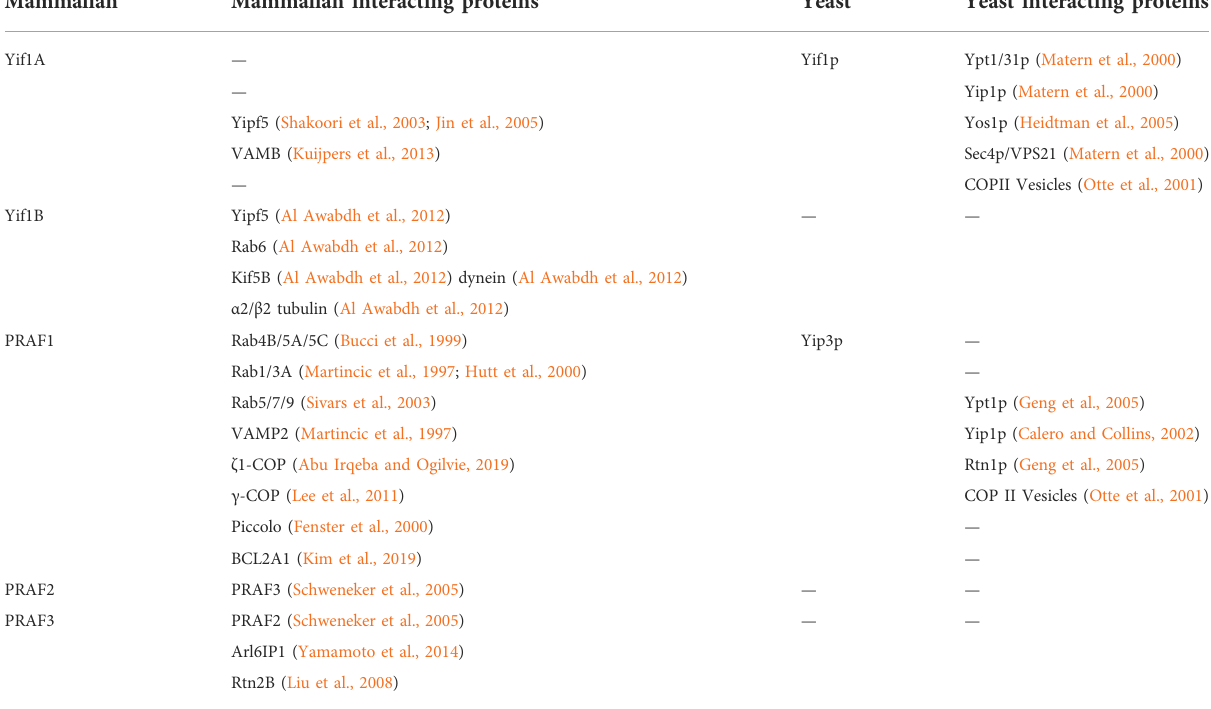
TABLE 6 Yif and PRA family interacting